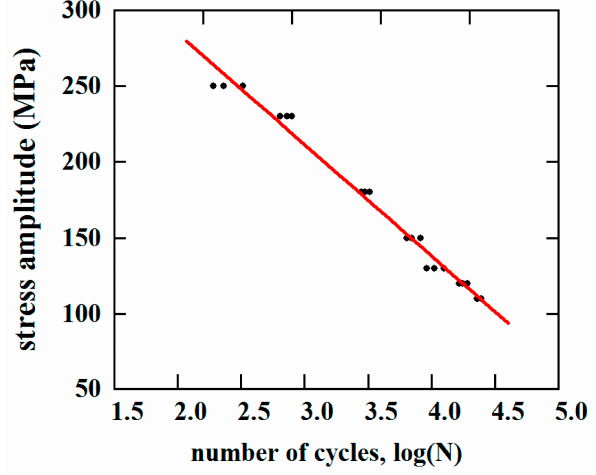
Table 5. S–N curve equations and parameters.